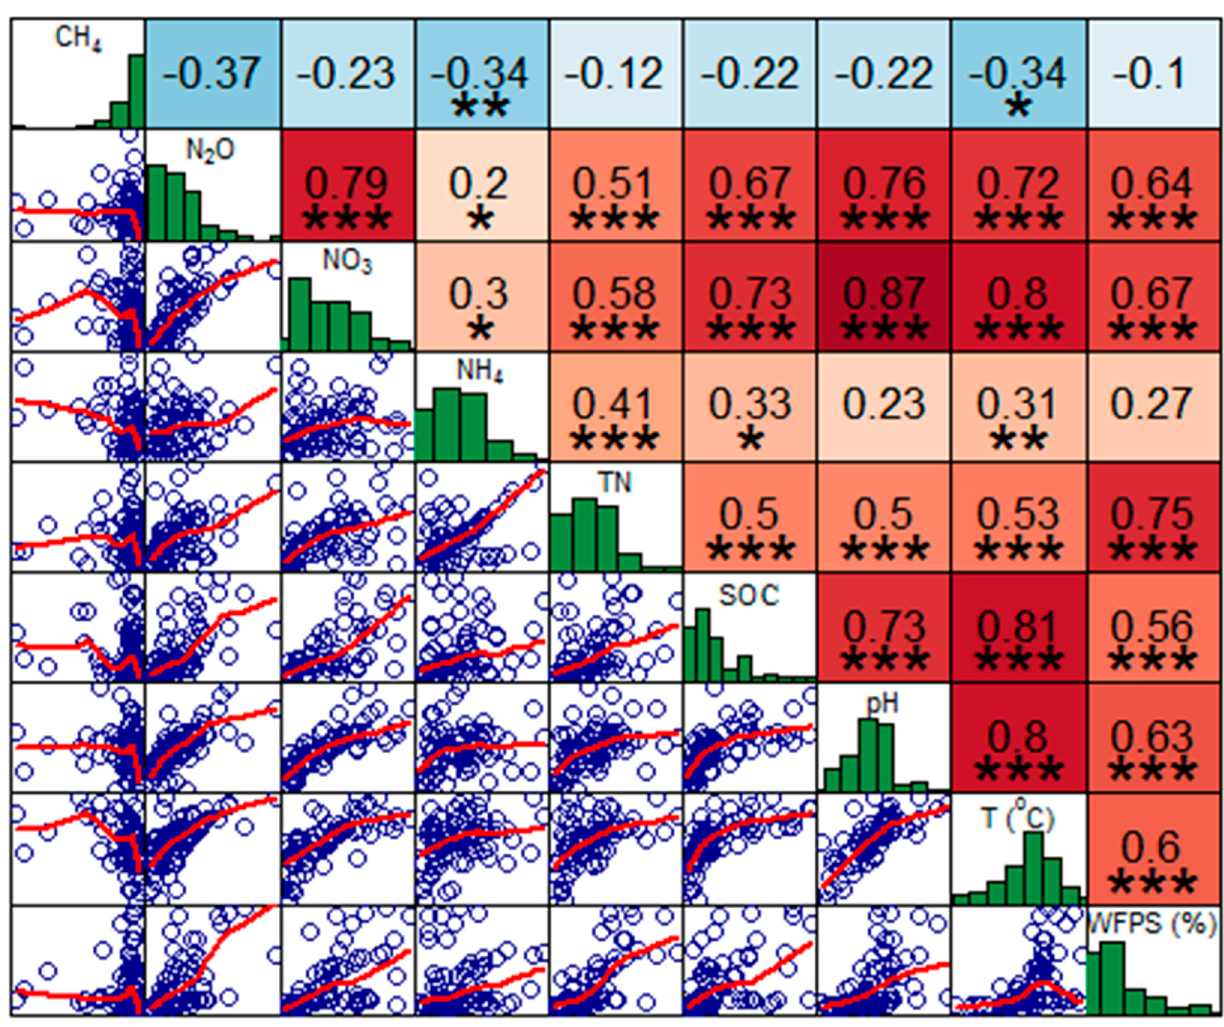
Figure 8. Correlations between GHG emissions and soil properties. N 2 O: nitrous oxide, CH 4 : methane, NO 3 − -N: nitrate nitrogen, NH 4+ -N: ammonium nitrate, TN: total nitrogen, SOC: soil organic carbon, T: soil temperature, WFPS: water-filled pore space. Significance levels: * 0.05, ** 0.01, *** 0.001. Negative correlations are highlighted in blue, and positive correlations are highlighted in red. A richer color indicates a stronger correlation. Dark blue indicates linear correlation.